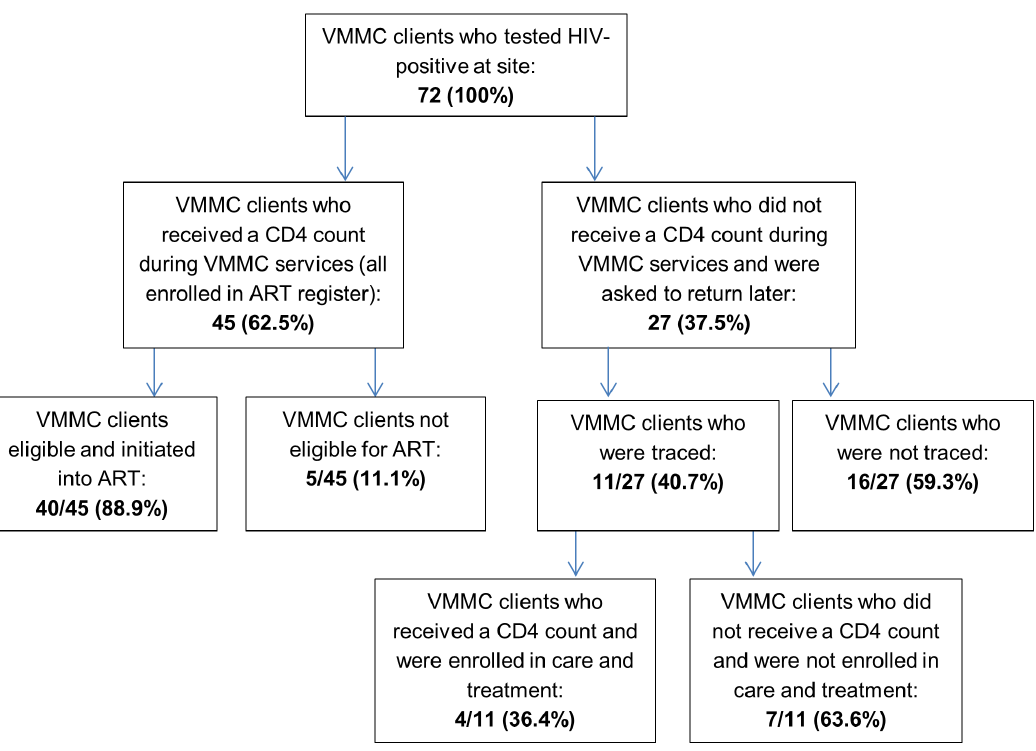
Figure 1. Flow chart describing ART enrolment outcome of VMMC clients who tested HIV-positive. All clients who received a CD4 count and who were eligible while seeking VMMC services were initiated on ART. Among the 27 clients who did not receive a CD4 count while seeking VMMC services, only four were enrolled in treatment.